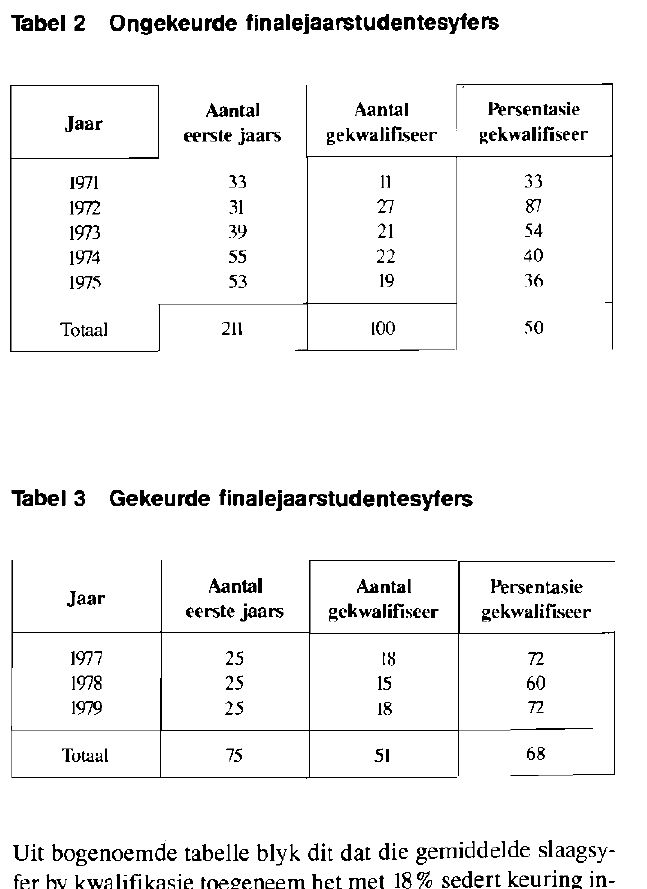
Uit bogenoemde tabelle blyk dit dat die gemiddelde slaagsy- fer by kwalifikasie toegeneem het met 18% sedert keuring in- gestel